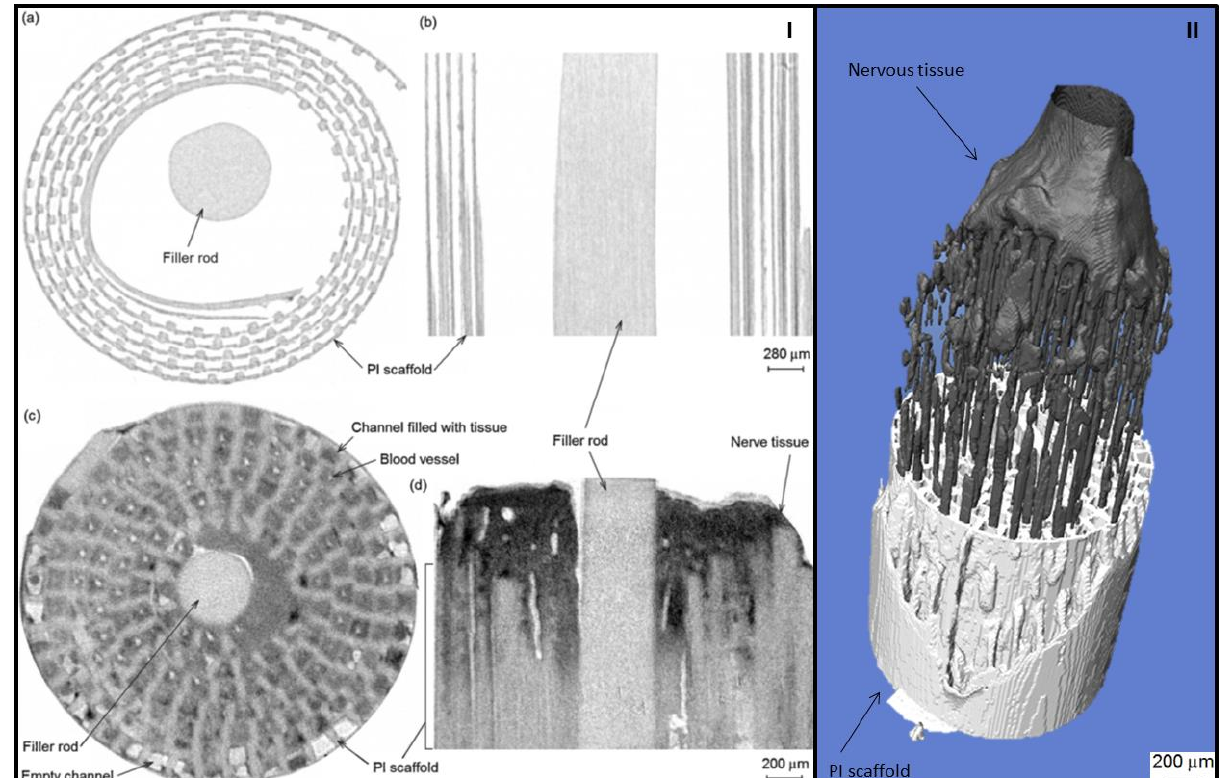
Figure 4. Panel I: µCT ( a ) horizontal cross-section and ( b ) vertical slice of empty nerve scaffold, showing PI scaffold (grey) and empty space (white). ( c , d ) show equivalent sections of a nerve scaffold with intergrowing tissue. Osmium stained tissue is dark grey, the PI scaffold is light grey, and empty space (PBS) is white. Tissue has grown down the majority of channels. Blood vessels can be seen as small white circles in the centre of channels (left) or as lines (right); panel II: 3-D model showing a 2 mm length of PI scaffold (white), and the intergrowth of regenerated tissue (black)—the position of the tissue as half of the scaffold is removed. Adapted with permission after [112], copyright Elsevier.